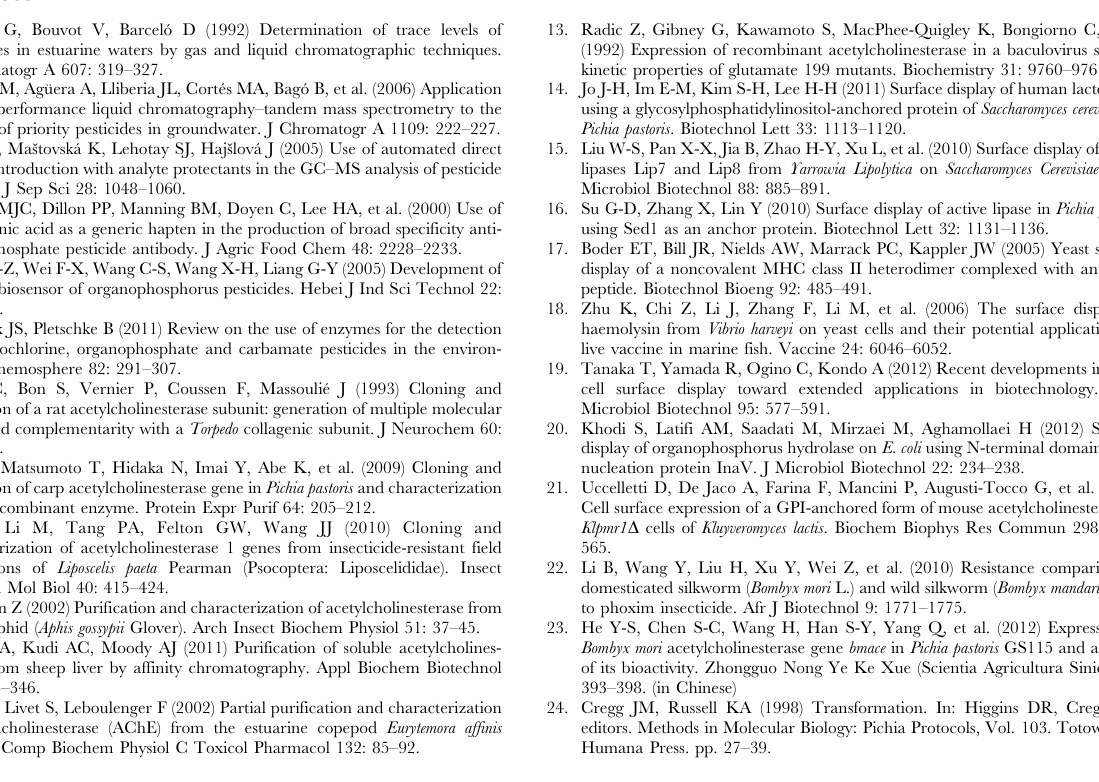
Figure S1 Nucleic acid sequence of the 2900 bp frag- ment.